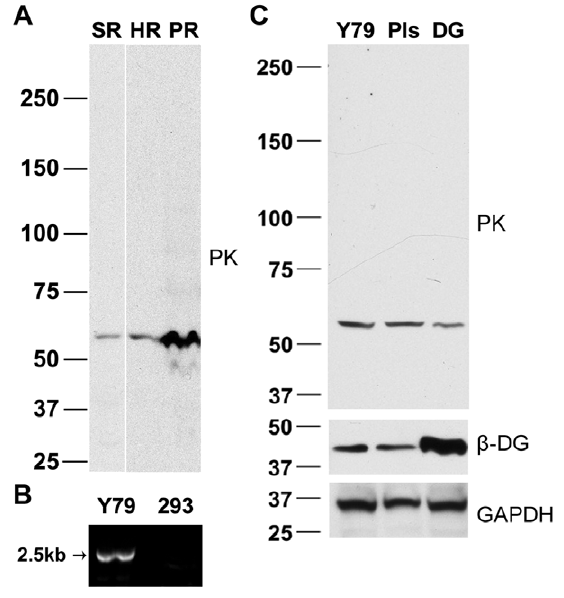
Figure 1. Endogenous pikachurin in retina and retina-derived cell lysates contains a , 60-kD band, presumed to be an N- terminal fragment. (A) Western analysis of pikachurin (PK) in salamander (SR), human (HR), and pig (PR) retina. (B) Pikachurin mRNA is expressed in Y79 retinoblastoma cells. RT-PCR results showed detectable signal in Y79 cells but not QBI-HEK293 cells. (C) A similar, 60-kD, pikachurin protein fragment was detected in untreated Y79 cells, which was not affected by protease inhibition in the culture media (PIs) or overexpression of murine dystroglycan (DG).